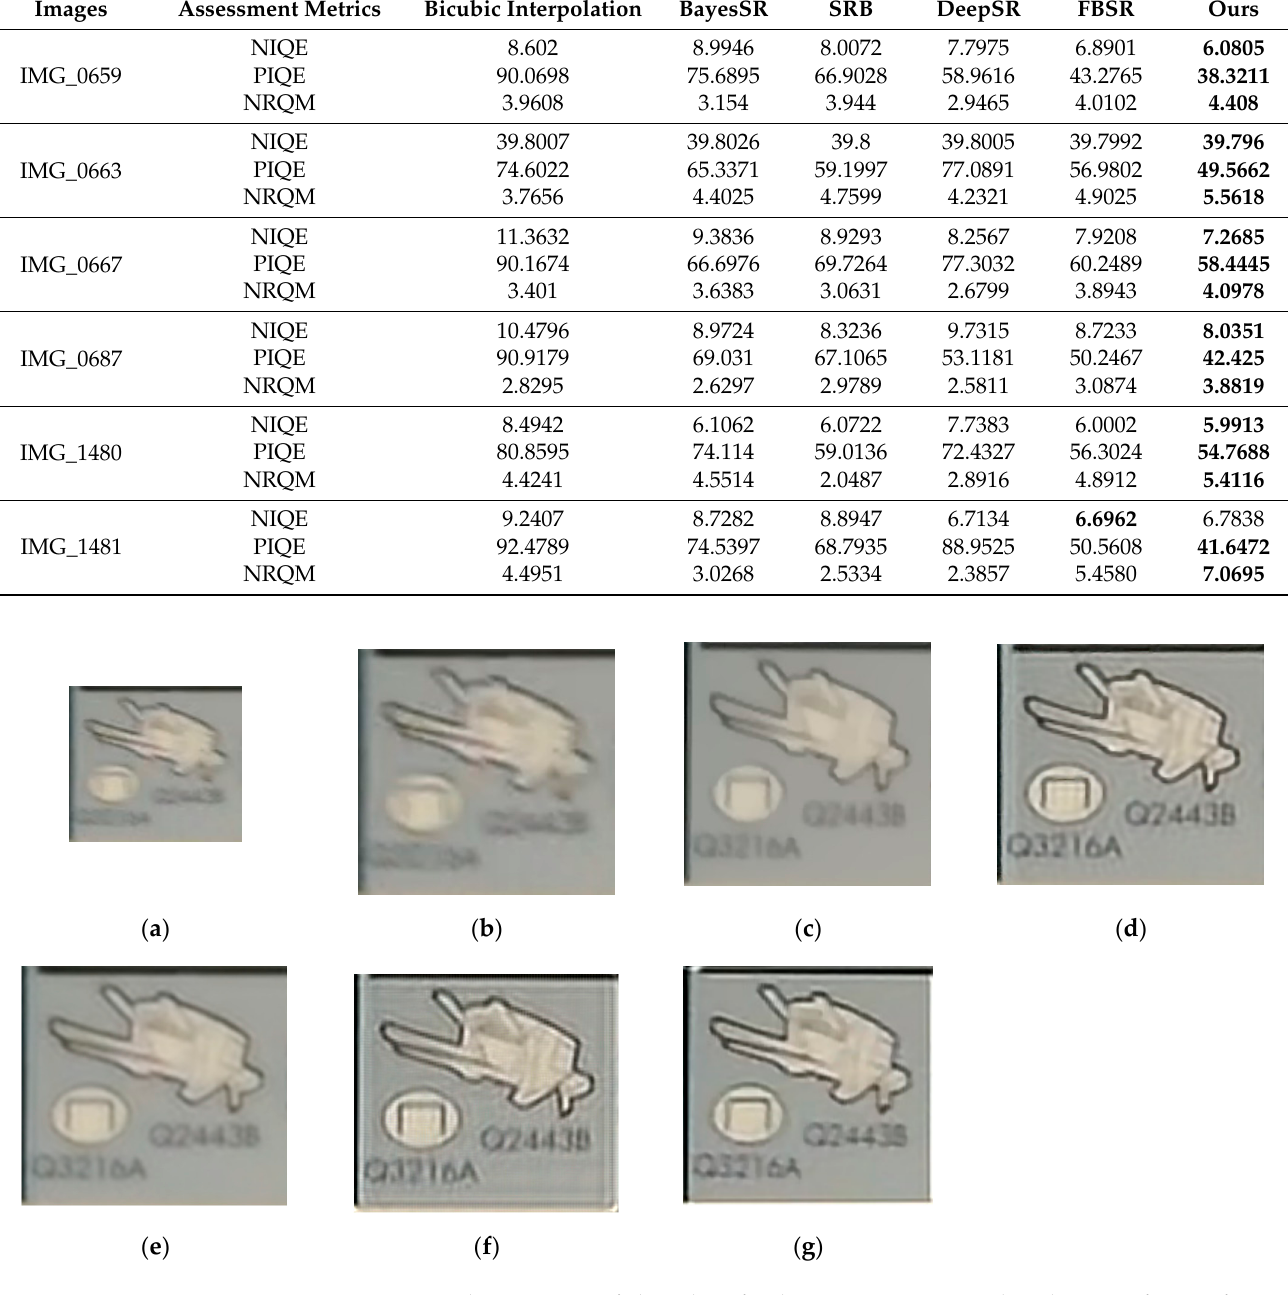
Figure 7. Visual comparison of algorithms for the IMG_0663 image when the magnification factor is 5. ( a ) The LR image; ( b ) Bicubic interpolation; ( c ) BayesSR; ( d ) SRB; ( e ) DeepSR; ( f ) FBSR; ( g )